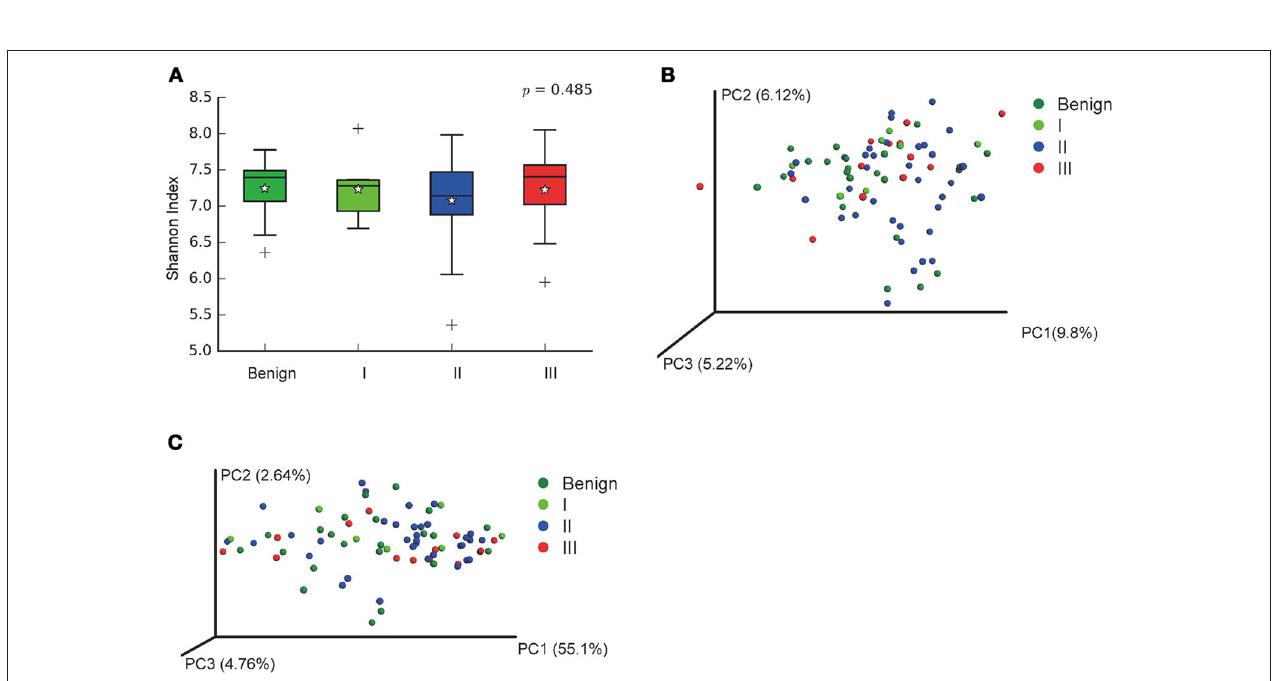
FIGURE 5 | Alpha and Beta diversity in malignant breast tumor tissue of different histological grade. (A) Boxplot compares Shannon index between benign and malignant ( P = 0.540, Kruskal-Wilcox’s H -test); (B) PCoA plots show the clustering pattern of the two groups based on unweighted UniFrac distance ( P = 0.502, Adonis); (C) PCoA plots show the clustering pattern of the two groups based on weighted UniFrac distance ( P = 0.853, Adonis). *indicates the mean of the data, the data points outside of the whiskers are shown as crosses + .